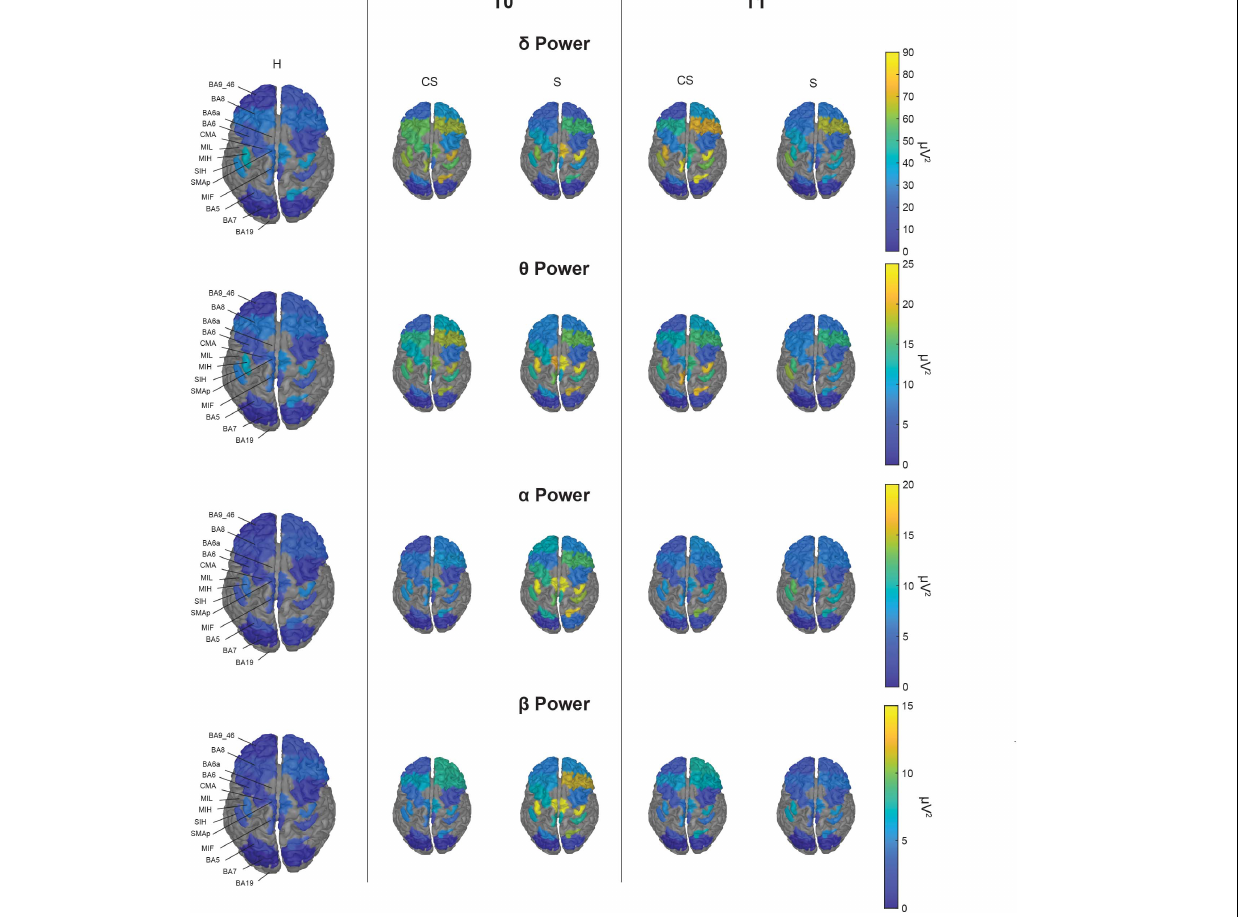
Frontiers in Human Neuroscience |